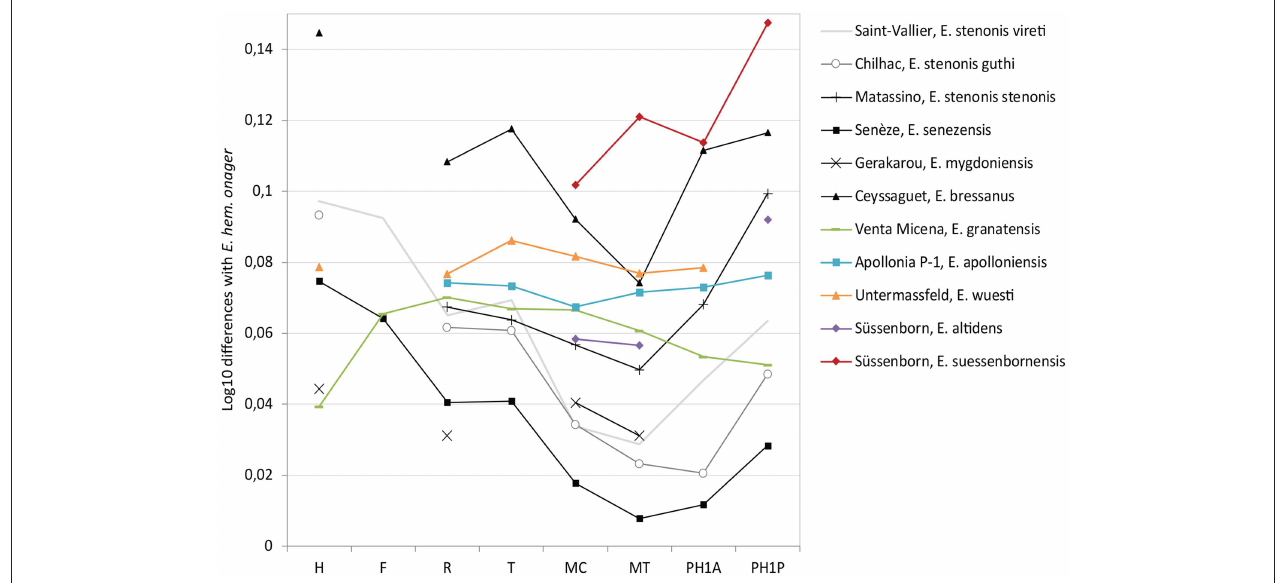
FIGURE 4 | Simpson’s ratio diagram of bone lengths of European Early and Middle Pleistocene horses. Reference: Equus hemionus onager (Eisenmann, 1991a). H, Humerus; F, Femur; R, Radius; T, Tibia; MC, Metacarpal; MT, Metatarsal; PH1A, First Anterior Phalanx; PH1P, First Posterior Phalanx. Data: Saint-Vallier